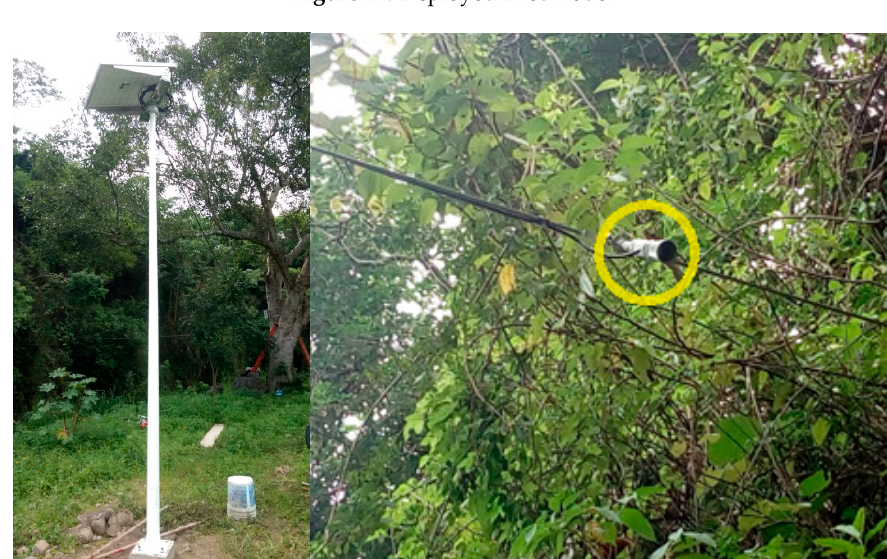
Figure 18. Positioned solar panel and ultrasonic sensor.